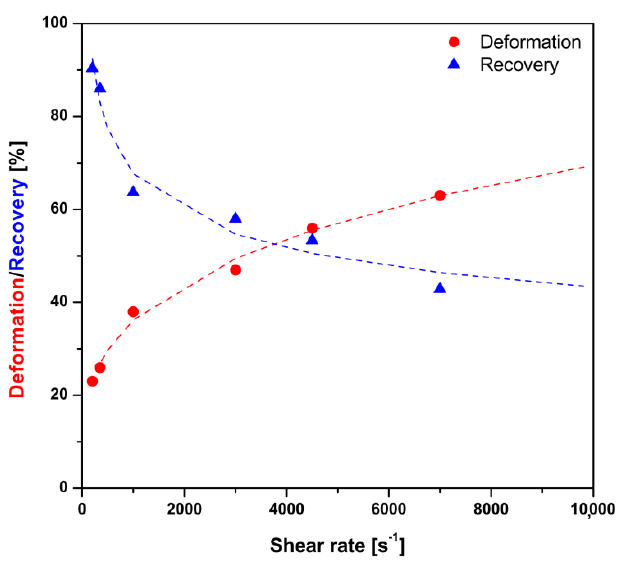
Figure 8. Dependence of deformation and recovery parameters as a function of the applied shear rate.